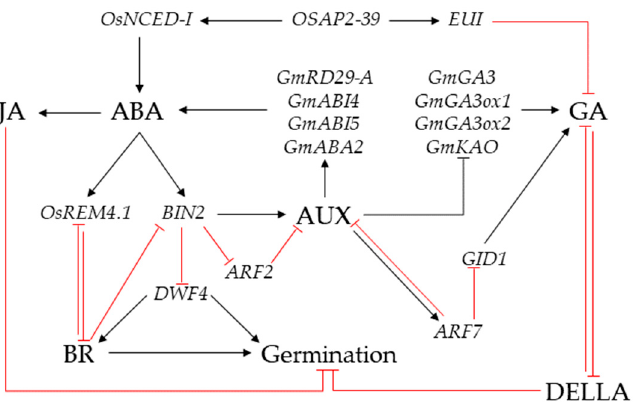
Figure 4. The interactions and regulatory signaling pathways through which the phytohormones GA, ABA, BR, AUX and JA influence seed germination. Arrow “ → ” indicates induction or promotion, while red bar “ ˧ ” indicates inhibition. Overexpression of OSAP2-39 upregulates the expression of OsNCED-I , a key enzyme in ABA biosynthesis, while the expression of the GA-inactivated gene EUI is also upregulated, resulting in a decrease in GA activity. ABA inhibits DWF4 expression by regulating the activity of BIN2 , a negative regulator of BR signaling that promotes the expression of auxin-related genes by inactivating the ARF2 auxin family transcriptional repressor, whereas enhanced BR synthesis and signaling inhibit BIN2 activity. ABA also inhibits BR signaling by activating the OsREM4.1 gene in rice, and BR inactivates OsREM4.1 . In the presence of BR, the activity of the negative regulator BIN2 is inhibited, thereby triggering the synergistic effect between BR and AUX. Auxin could significantly inhibit the expression levels of GmGA3 , GmGA3ox2 , GmGA3ox1 and GmKAO and upregulate the transcription levels of GmABI4 , GmABI5 and GmRD29-A , thus reducing